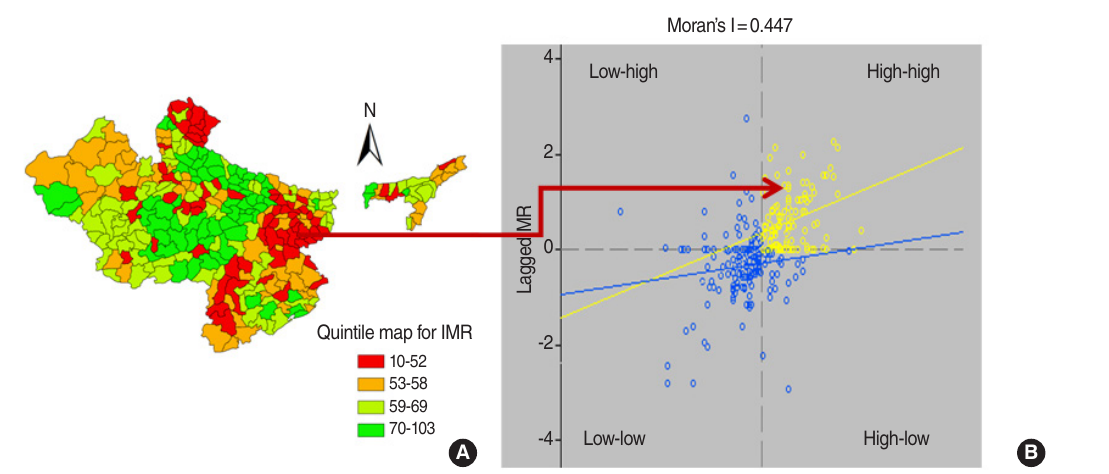
Figure 2. (A) Quintile map for infant mortality rate (IMR) for 2010-2011. (B) Moran’s I scatter plot for IMR for 2010-2011.